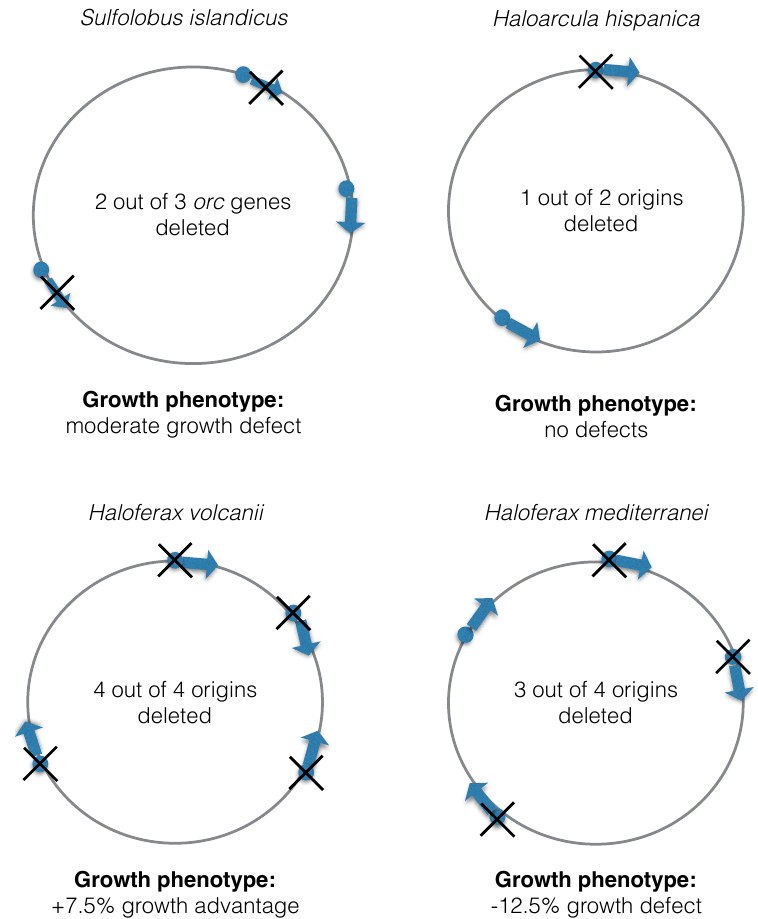
Figure 3. Serial deletion of orc genes or origins in different archaeal species. The highest number of orc /origin deletions possible in one strain is shown. Chromosomes are not drawn to